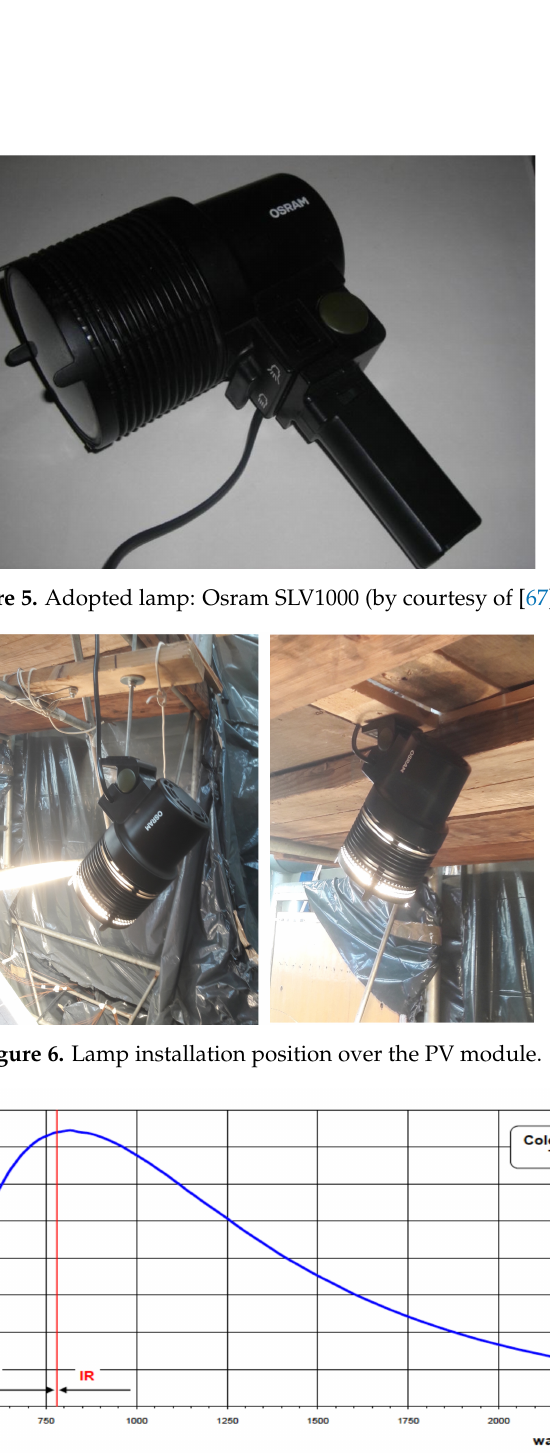
Figure 7. Lam spectral distribution. By courtesy of